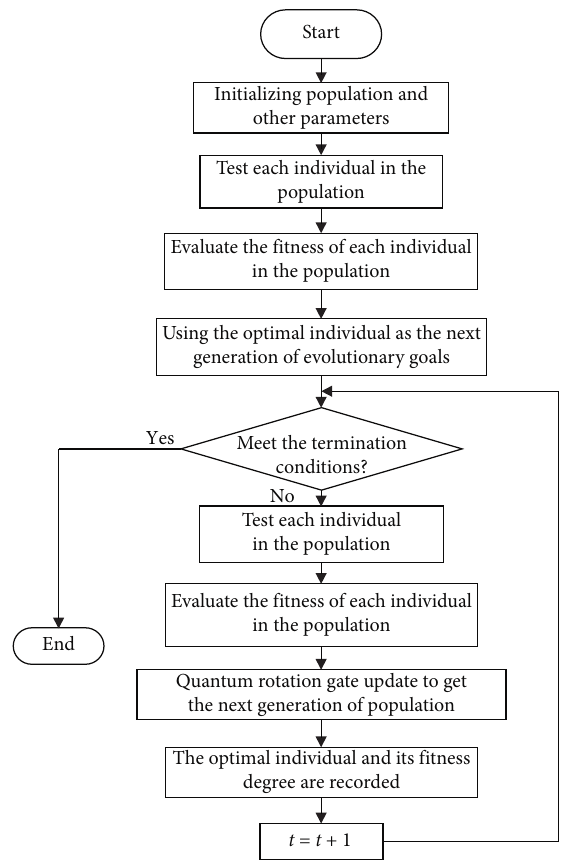
Figure 2: Flowchart of